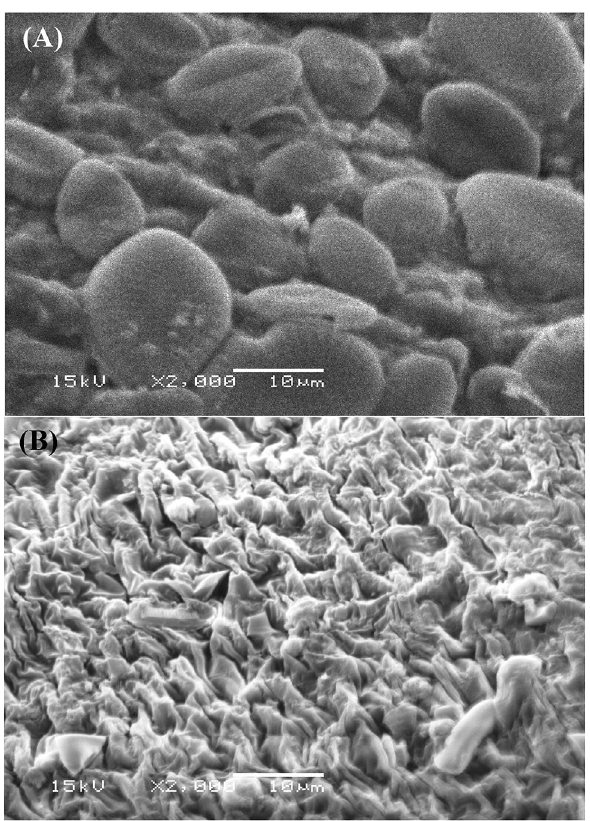
Figure 7. SEM micrograph of Gelidium corneum biomass: ( A ) before and ( B ) after simultaneous biosorption of Hg 2+ and Remazol brilliant blue